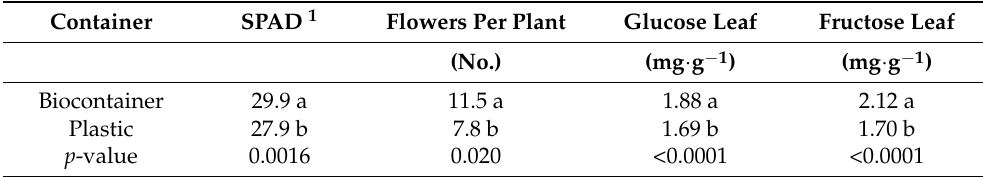
Table 3. Leaf SPAD, flower count, glucose and fructose concentrations in Encore ® azalea ‘Chiffon’ varied between container